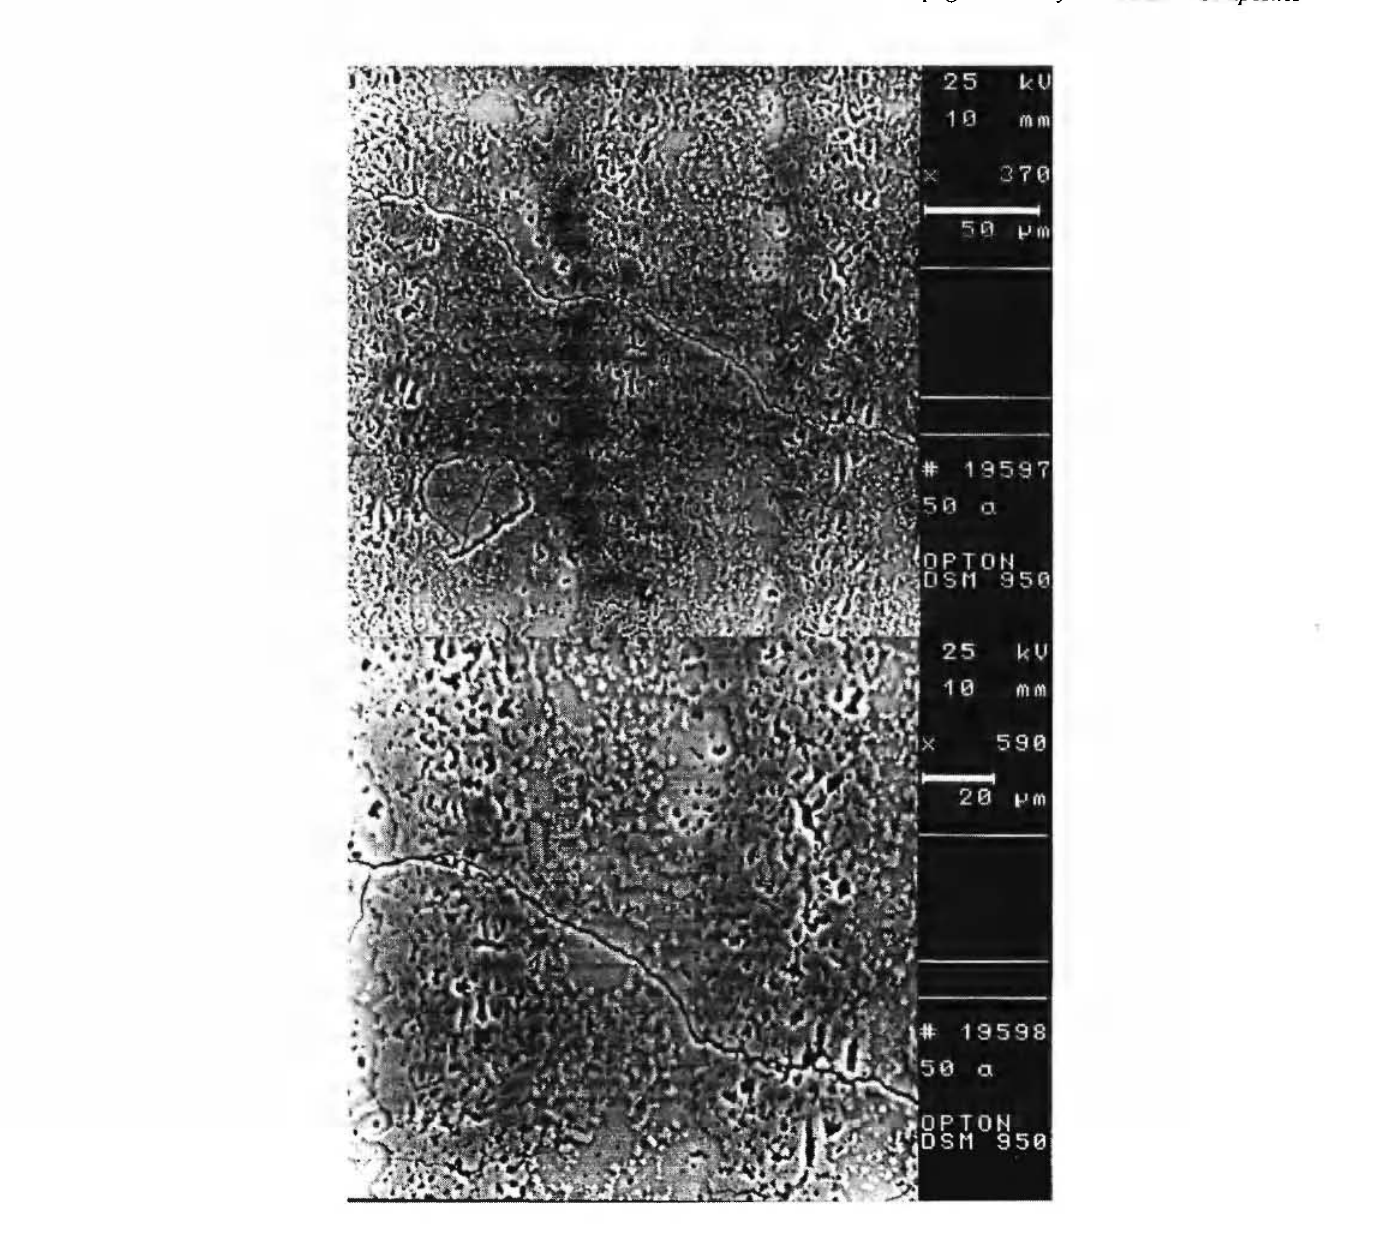
Fig. 2: Crack path in Al 2 0 3 /mullite composite with 50μηι thick mullite barrier layers: the crack is deflected in mullite layers, in alumina layers (layer with pores) it propagates perpendicularly to the layers.